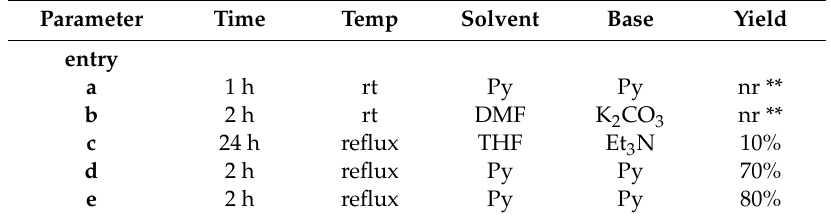
Table 1. Conditions of reaction to obtain bisteroids derivatives from cholesterol ( 3 ) and diosgenin ( 7a ) *. Parameter Time Temp Solvent Base Yield entry a 1 h rt Py Py nr ** b 2 h rt DMF K 2 CO 3 nr ** c 24 h reflux THF Et 3 N 10% d 2 h reflux Py Py 70% e 2 h